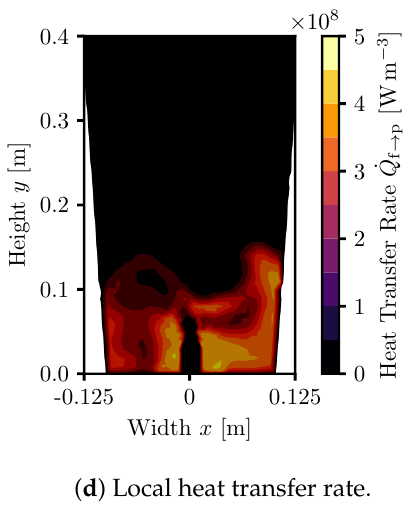
Figure 9. Instantaneous simulation snapshots showing gas and particle temperature, spray cloud, water concentration in the gas phase and the rate of heat transfer in the apparatus midplane ( z = 0). The process conditions were set for the reference case at a fluidization gas velocity ˙ V 3 h 1 and temperature T − air = 105Nm air,in = 85°C, an atomization pressure of p spray = 1.8bar and a spray air temperature of 70°C, corresponding to experiments